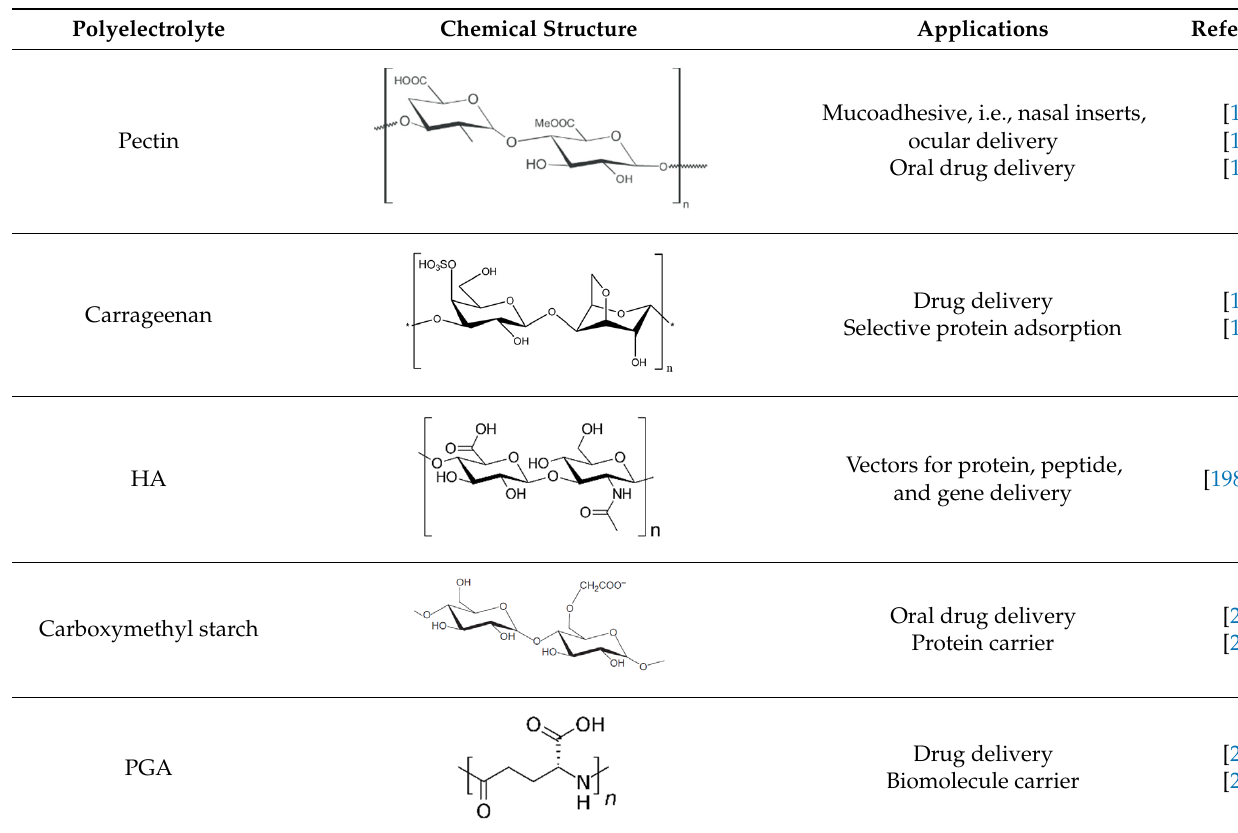
Table 7. Cont . Polyelectrolyte Chemical Structure Applications